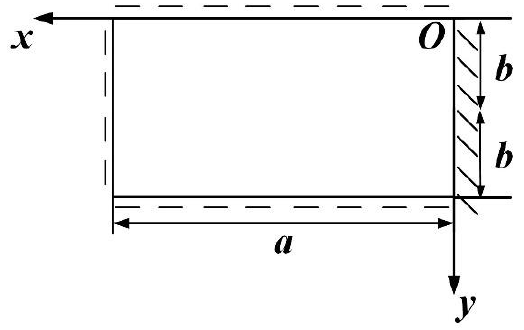
Figure 7. ‘Plate’ mechanical model of periodic fracture of roof.